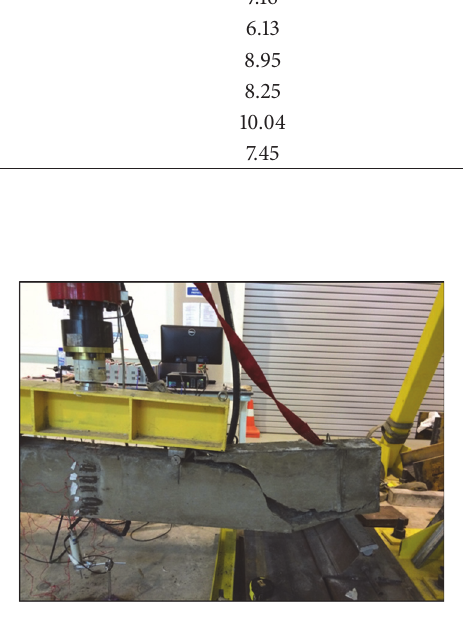
Figure 10: Typical shear failure mode of beams B7 and